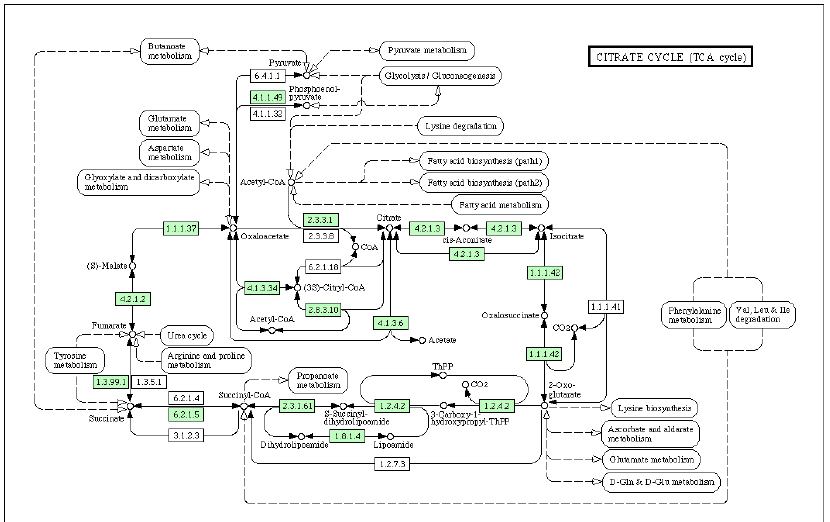
Figure 6: A visualisation of the tricarboxylic acid (TCA) cycle of Escherichia coli from the KEGG website [11].